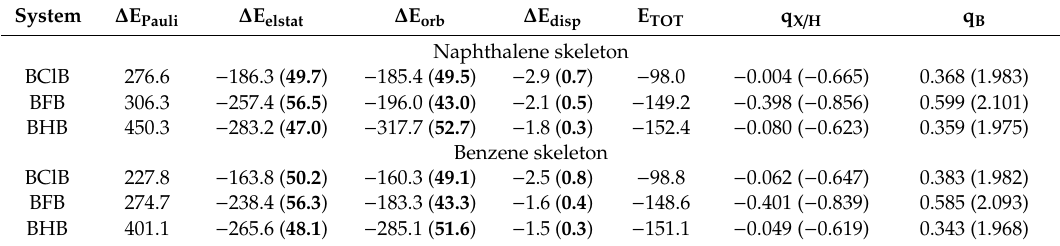
Table 3. The interaction energy terms (in kcal / mol) for the systems analyzed here; for the attractive terms, their percentage contributions (bolded) are given in parentheses The NBO and QTAIM charges (both in au, the latter ones in parentheses) of the atoms of the B–(H / X)–B links are included: hydrogen and halogen charges, q H and q X , respectively, and the charges of the boron centers. The charges of both boron centers for all systems were equal or almost equal; thus, one mean boron charge for each link is given, q B